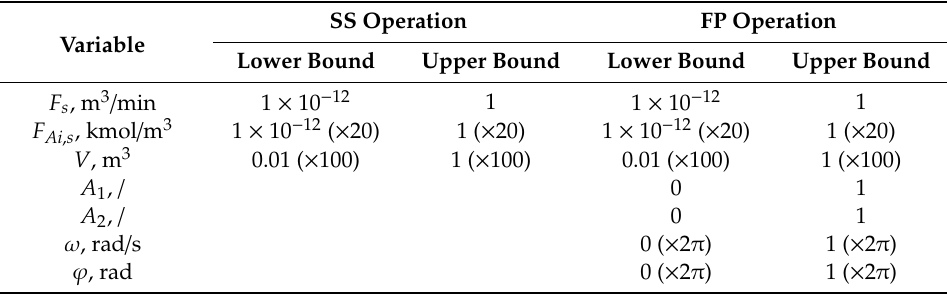
Table 1. Pareto optimization variables for Example 1: CSTR and its corresponding lower and upper